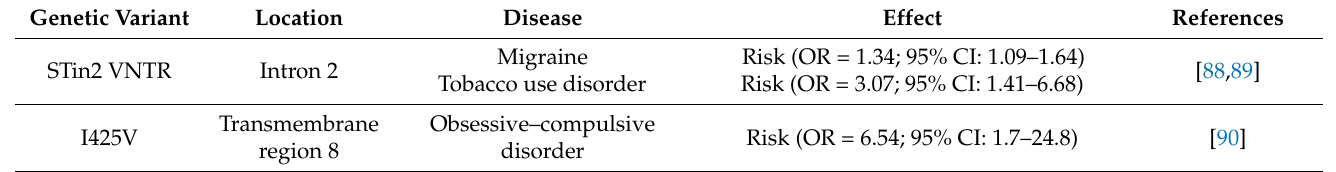
Table 1. Serotonin Transporter (SERT) genetic variants and their relation with human diseases. Genetic Variant